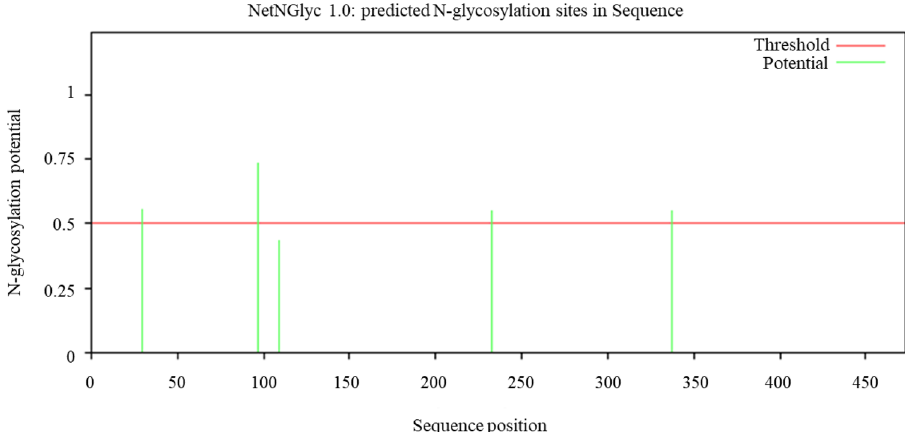
Figure 4. NetNGlyc 1.0 identification of several potential N -glycosylation sites in carboxypeptidase CapA. The potential N -glycosylation sites are those that are above the threshold (0.5), with the highest peaks indicating the greatest potential for